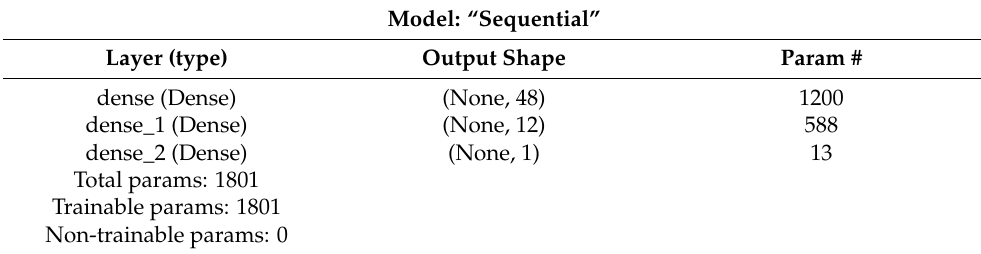
Table 1. Neural Network Model Architecture.